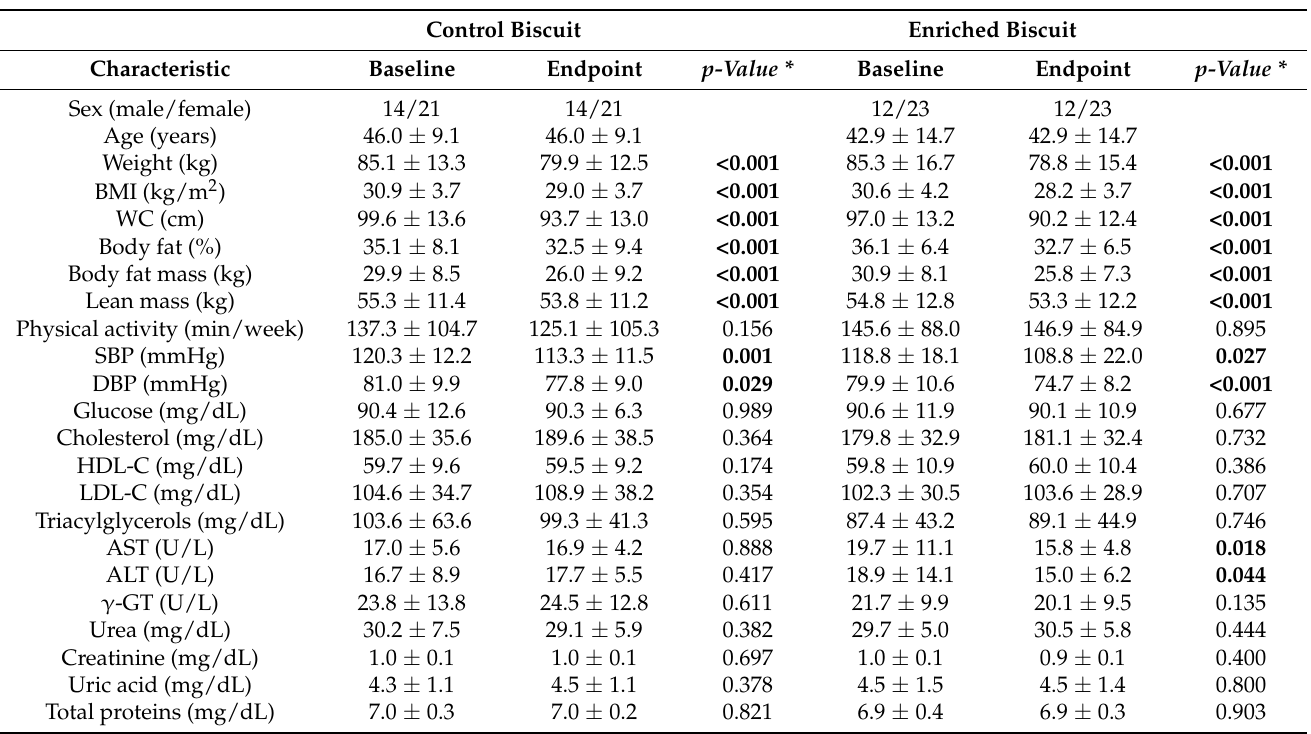
Table 2. Anthropometric, clinical and biochemical characteristics of the subjects at baseline and after 12 weeks.